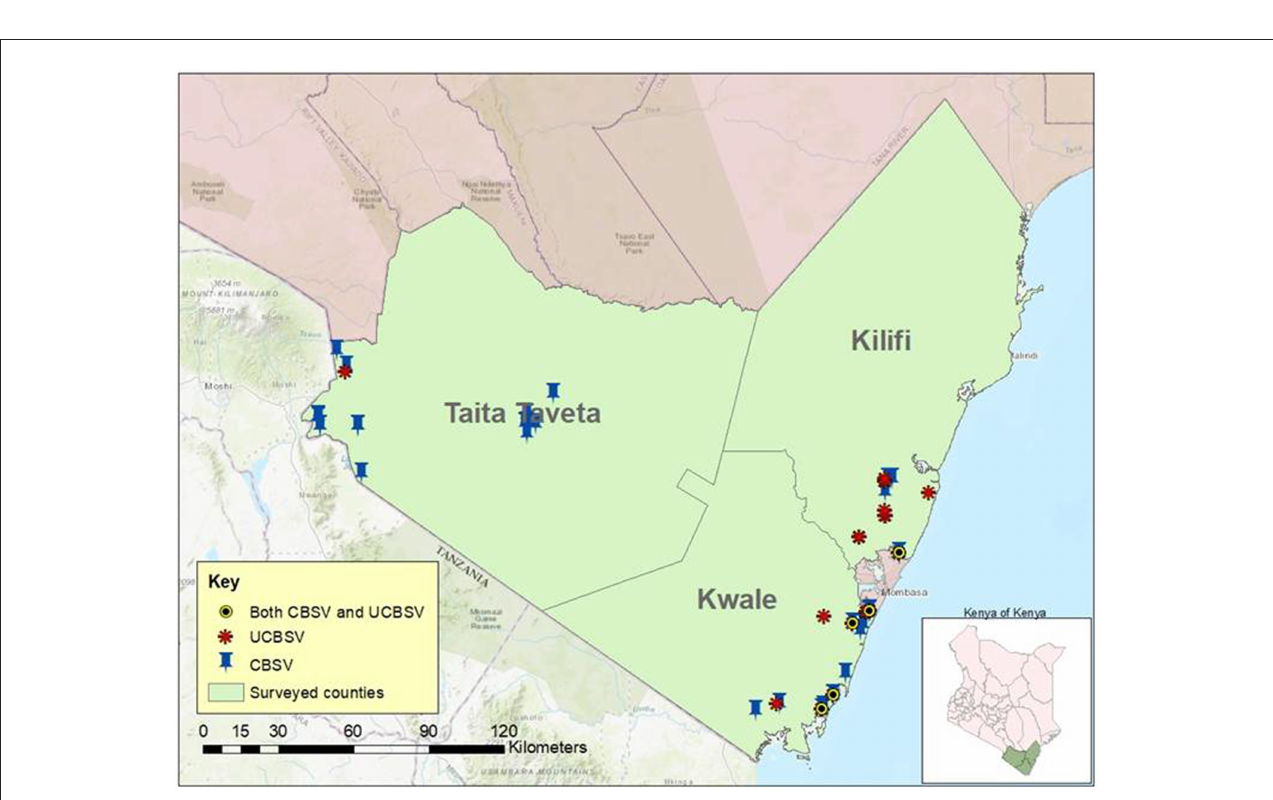
FIGURE3 Distribution of cassava brown streak viruses mapped based on 153 cassava fields surveyed in Kilifi, Kwale and Taita Taveta counties of coastal region in Kenya.